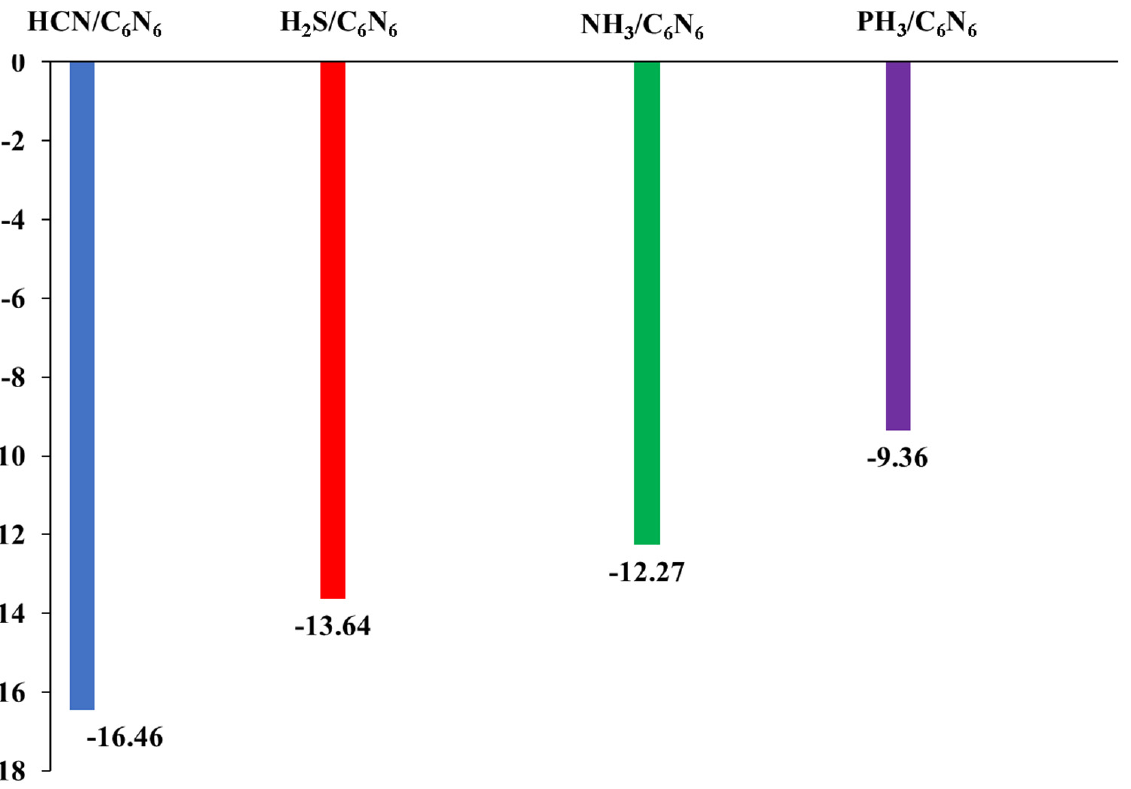
Figure 1. Graphical representation of adsorption energies of analyte@C 6 N 6 complexes at the Ꞷ b97XD/6-31G (d,p) level of